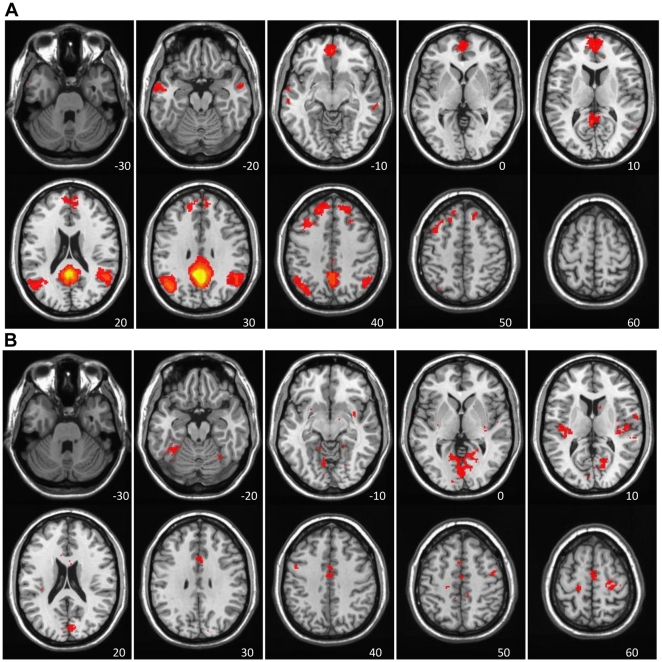
Conjunction analyses of LV1 and LV2.Conjunction analyses of LV1 and LV2, highlighting stable and variable DN regions. A) Stable DN regions – voxels showing positive brain scores, and positive FC, on both LVs (red regions in both Figure 1 and 2). B) Variable DN regions – voxels with positive brain scores (positive DN connectivity) on LV1 (red regions in Figure 1) and negative brain scores (negative DN connectivity) on LV2 (blue regions in Figure 2). The colors represent the conjunction “BSR” values, which are a product of the BSR values of the original maps, thereby highlighting common “hotspots”.